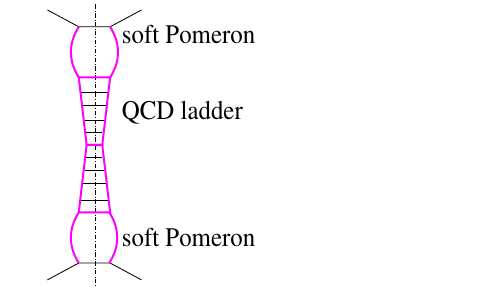
Figure 5. Schematic view of a semihard scattering process: perturbative parton evolution is represented by the ladder; the “blobs” above and below the ladder correspond to nonperturbative parton cascades described as soft Pomeron